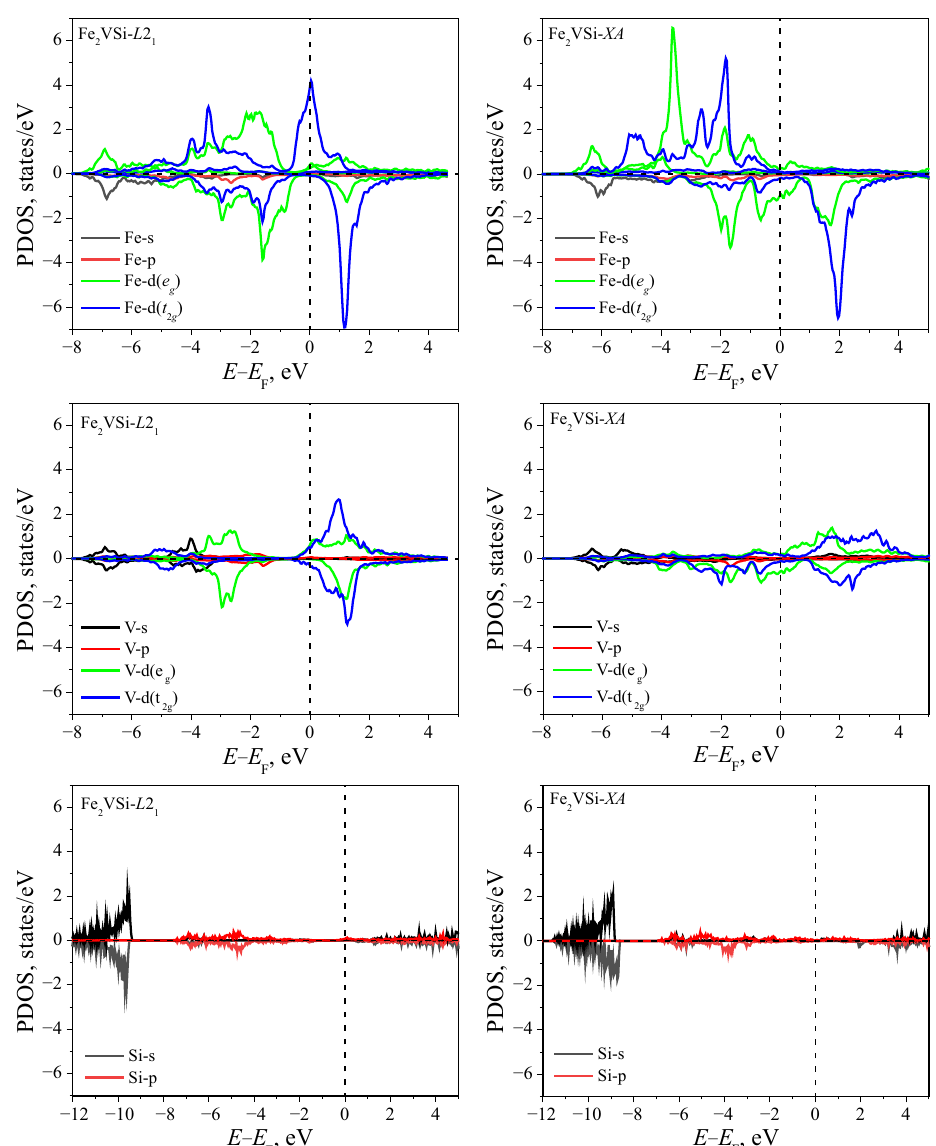
Figure 4. The partial density of states for Fe 2 VSi of both L 2 1 and XA structures. Zero on the energy axis corresponds to the Fermi